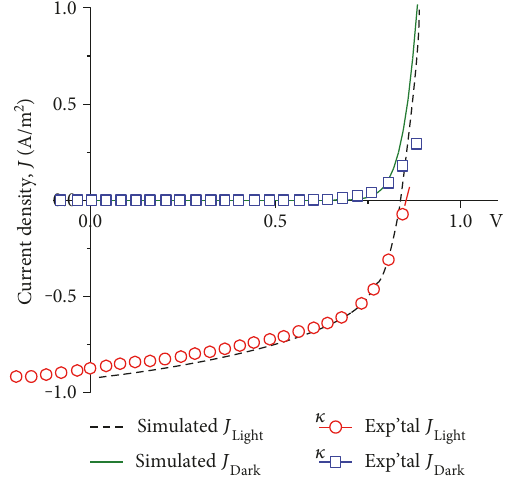
Figure 6: Comparison of 2D simulated J-V characteristics of an OPV solar cell system with perfect planar interface with experimental pro fi les ( K ) adapted from Koster et al.